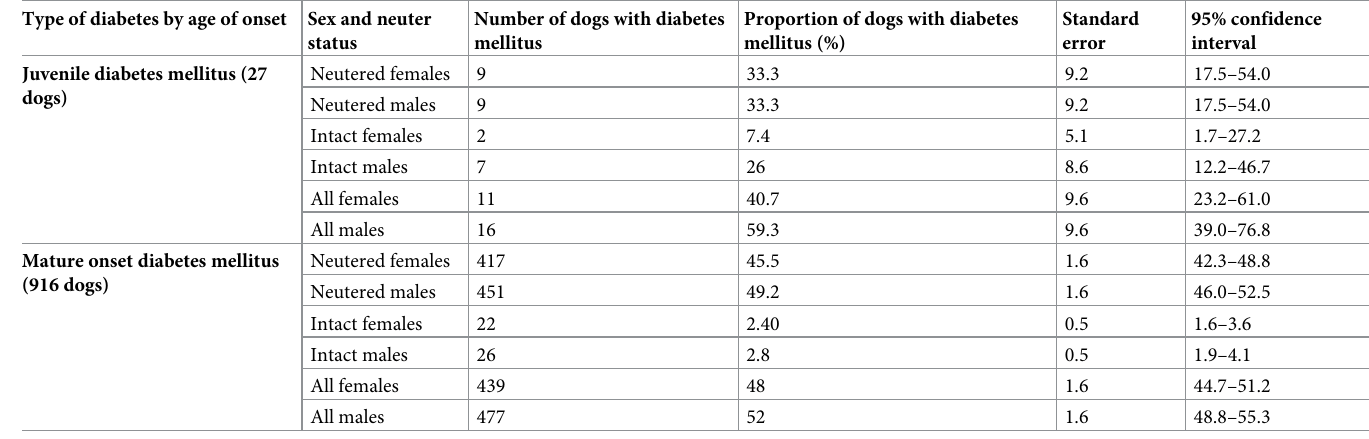
Proportion of dogs with diabetes mellitus (%)